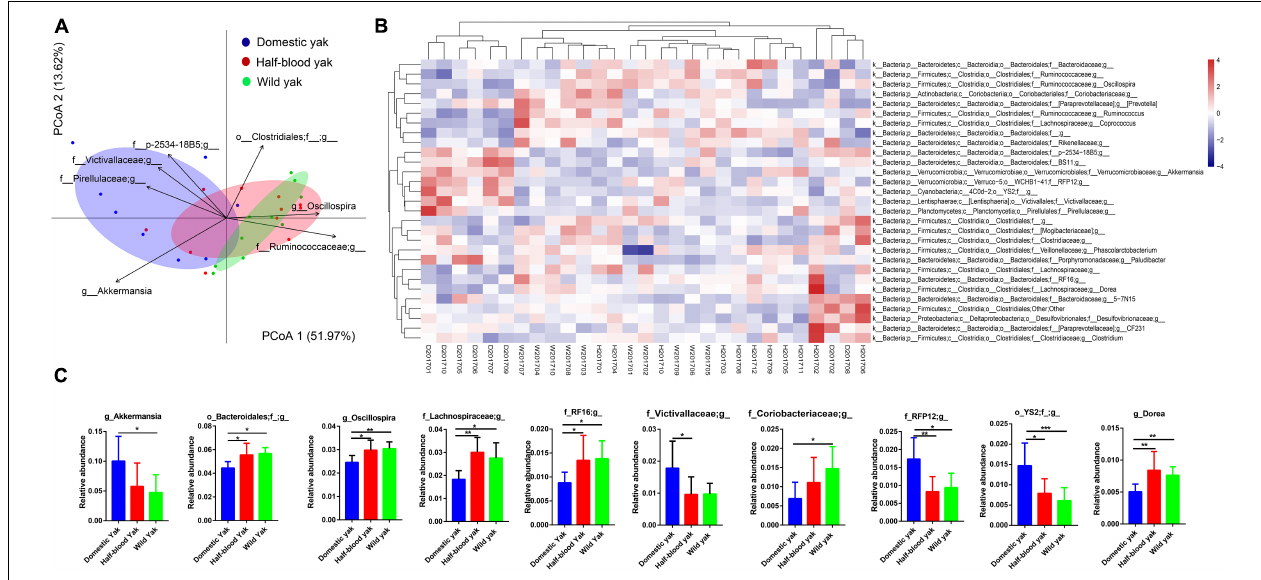
FIGURE 2 | Composition of fecal microbiota of the three types of yaks at the genus level, the letters “D,” “H,” and “W” represent domestic, half-blood, and wild yaks, respectively. (A) Bray-Curtis dissimilarity of gut microbial communities among the three types of yaks based on top 30 genera, ellipses with 95% confidence interval around the centroid of each group are displayed in PCoA, the genera which have significant correlation with the ordination in PCoA are displayed using the arrows (permutation test, p < 0.01), with the length of the arrow representing the goodness of fit statistic, squared correlation coefficient. (B) Heatmap of the top 30 genera based on the relative abundance of gut mcirobiota among the three types of yak, complete linkage clustering was used. (C) Relative abundance of the gut microbiota indicating the significantly discrepancies among the three types of yak at the genus level across 29 samples, asterisks indicate significance level between groups ( p > 0.05, no significance; p < 0.05, *; p < 0.01, **; p < 0.001, ***).